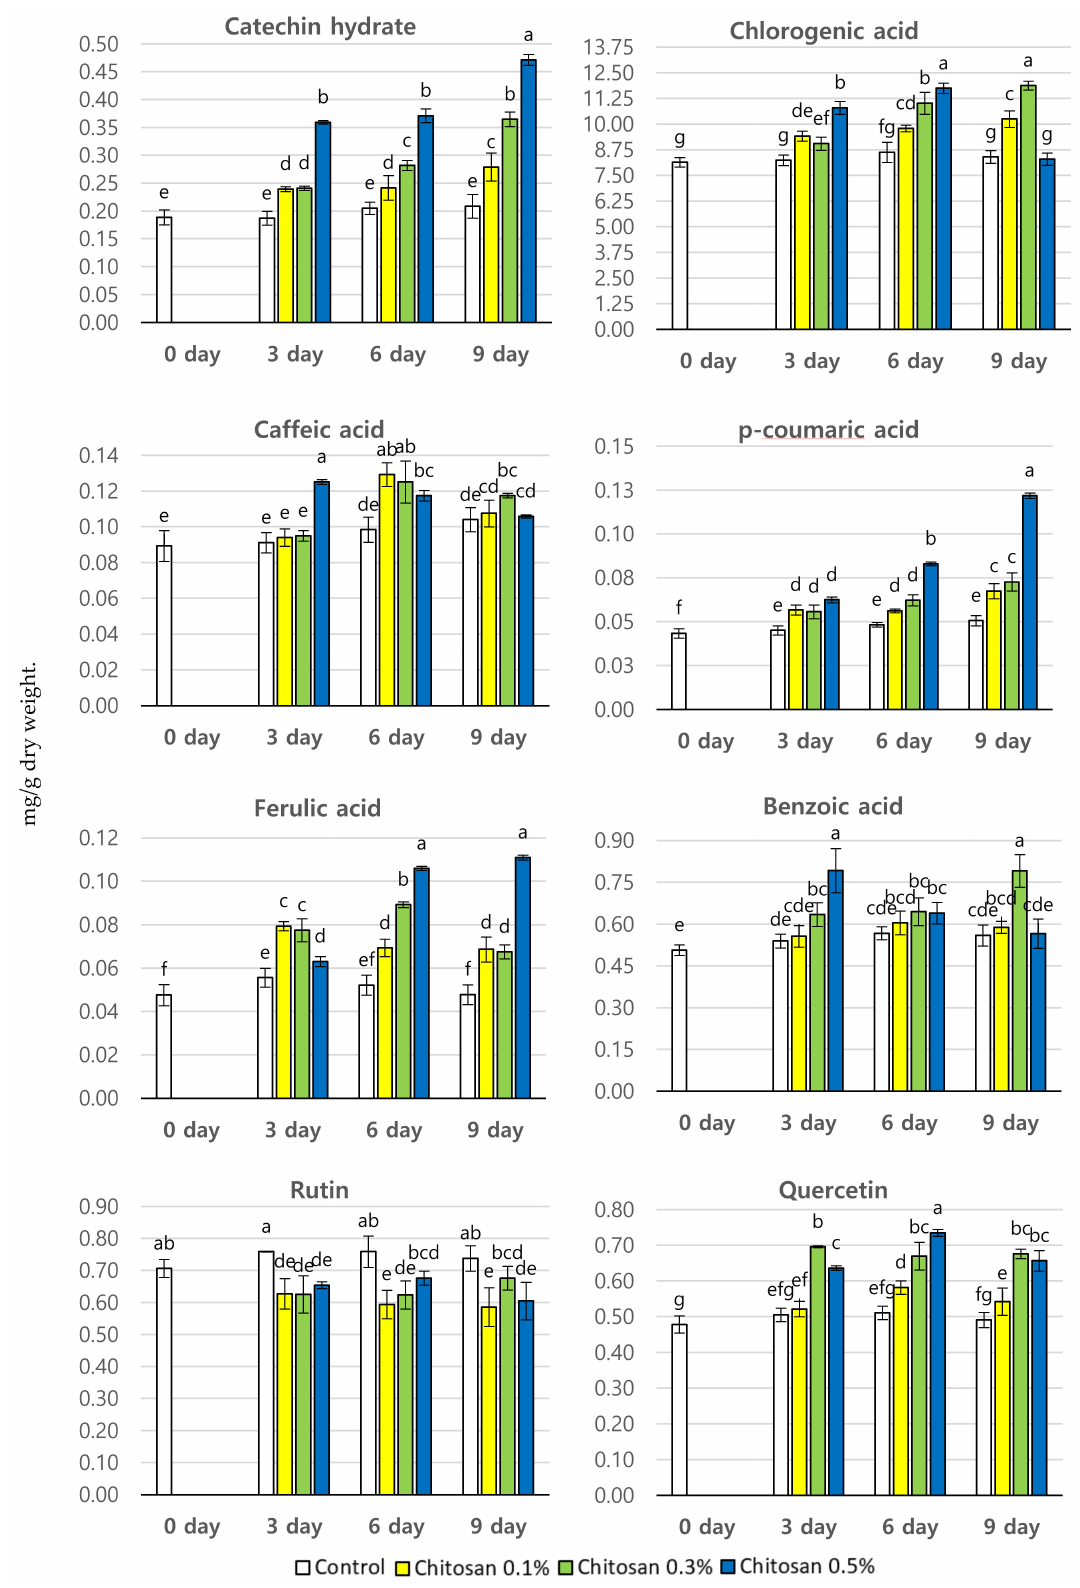
Figure 4. The content of phenolic compounds (mg / g dry wt.) in P. brachycarpa Nakai samples taken at di ff erent harvesting days after treatment with di ff erent chitosan concentrations. The values marked above the bars with di ff erent letters (a–f) indicate statistically significant di ff erences between treatments, as determined using DMRT ( p <